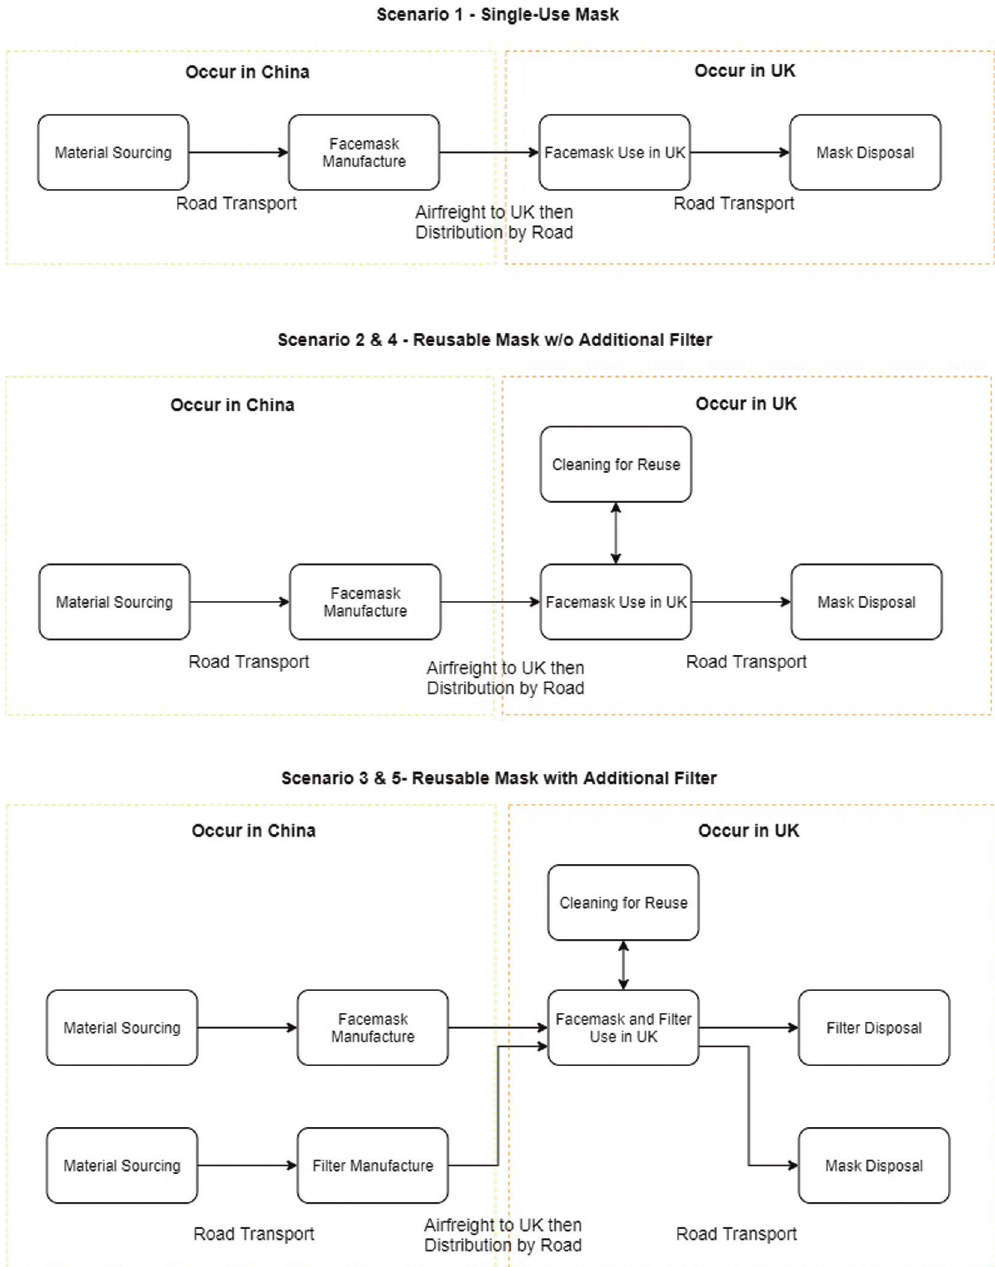
Cradle-to-grave system boundary for each face mask use